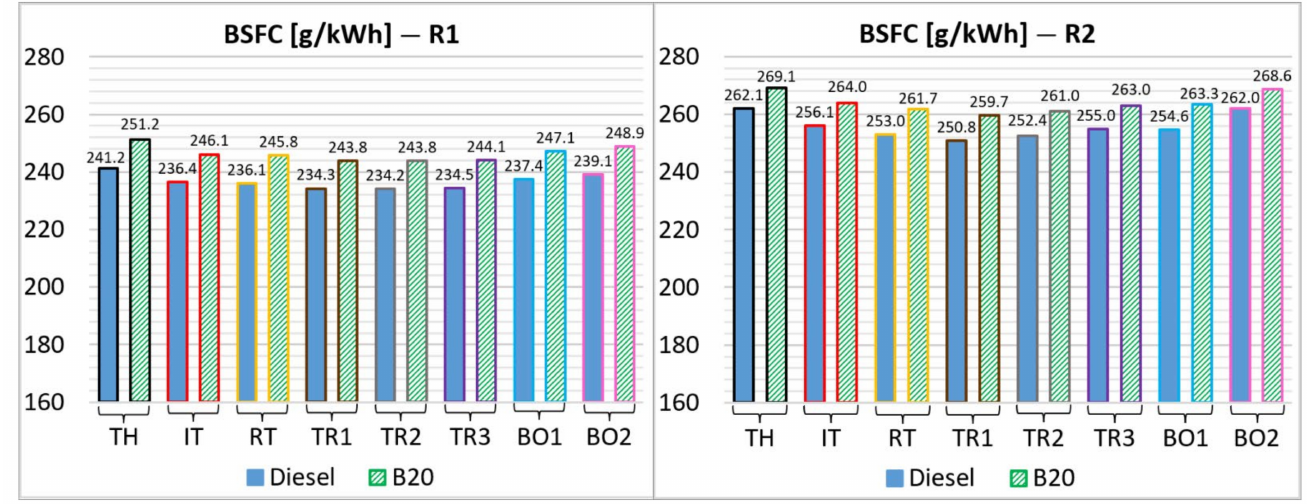
Figure 12. Brake-specific fuel consumption (BSFC) variation by different shapes of